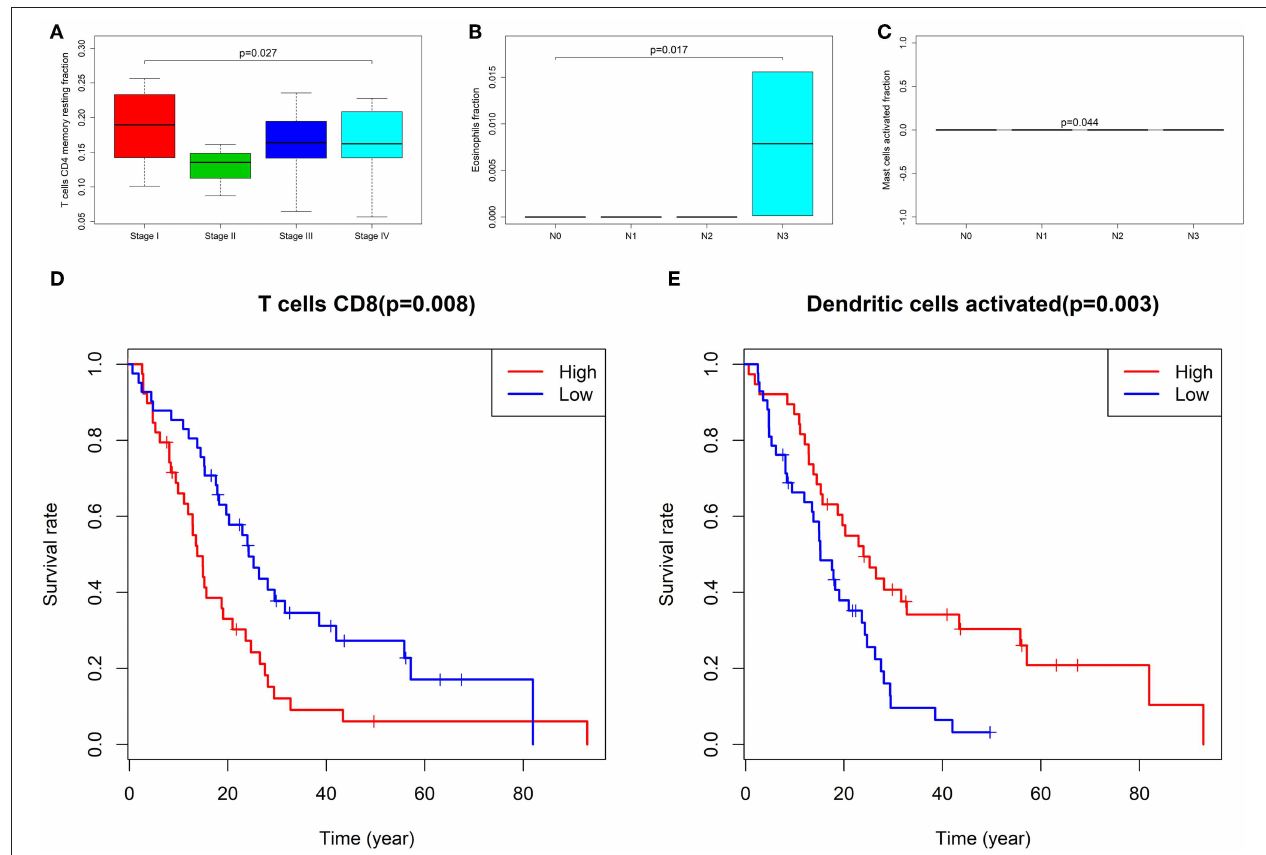
FIGURE 6 | The fraction of T cells CD4 memory resting between four stages of cancer (A) ; the fraction of eosinophils (B) and Mast cells activated (C) between T groups; the Kaplan–Meier survival curves of Fraction of T cells CD8 (D) and Dendritic cells activated (E)